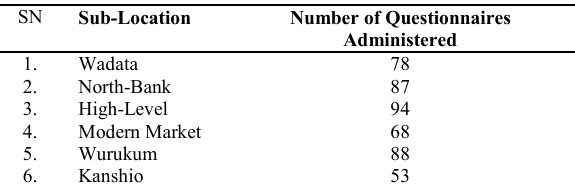
Table 3: Questionnaires distribution